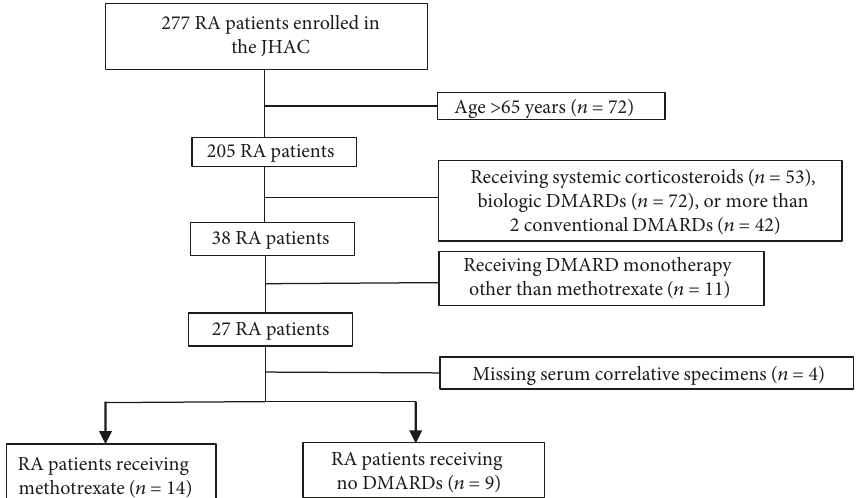
Figure 1: Flow diagram shows selection of patients included in our study. A total of 23 RA patients from the JHAC were included in the fi nal analysis. Abbreviations: RA =rheumatoid arthritis; JHAC=Johns Hopkins Arthritis Cohort; DMARDs =disease-modifying antirheumatic